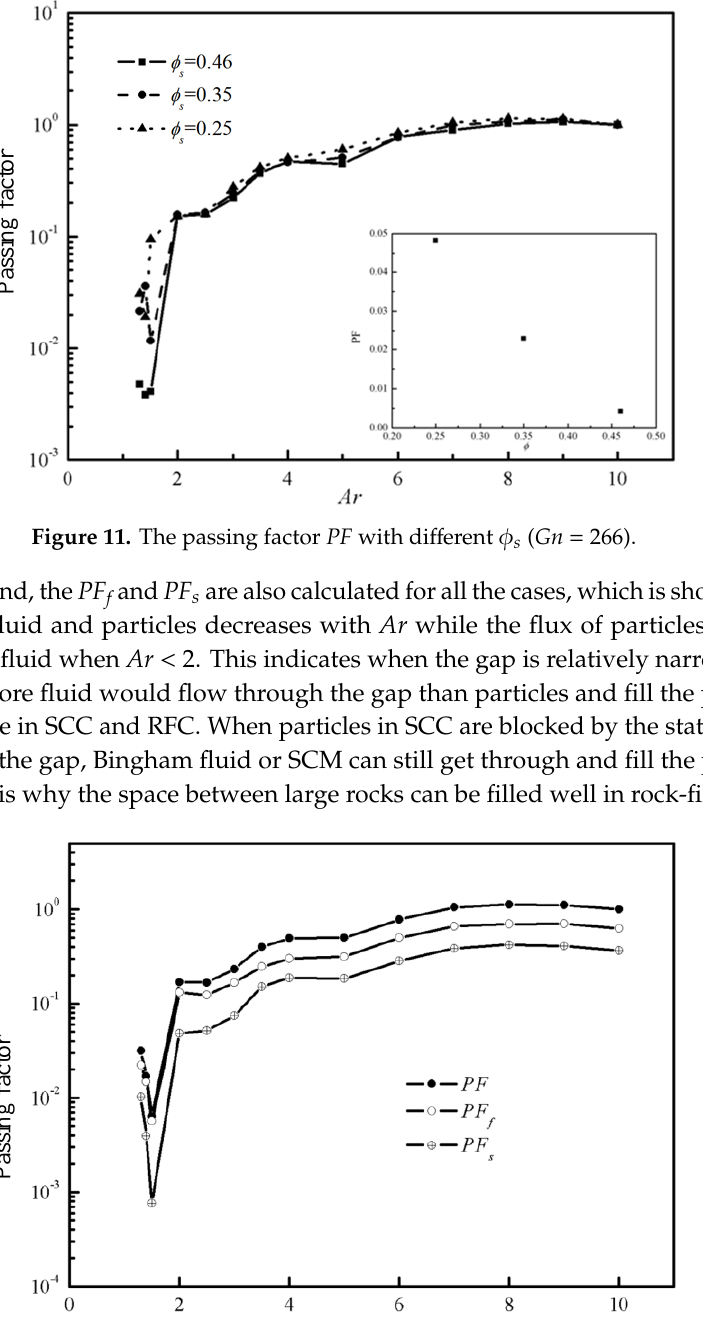
Figure 12. The passing factor PF, PF f , PF s when Gn = 133, ϕ s = 0.35.